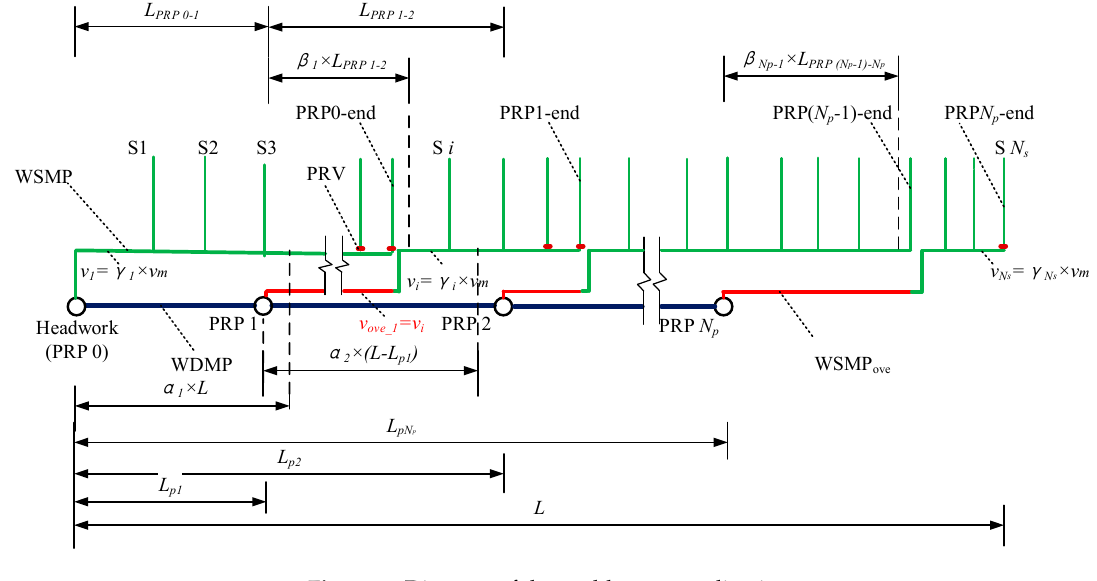
Figure 3. Diagram of the problem generalization.